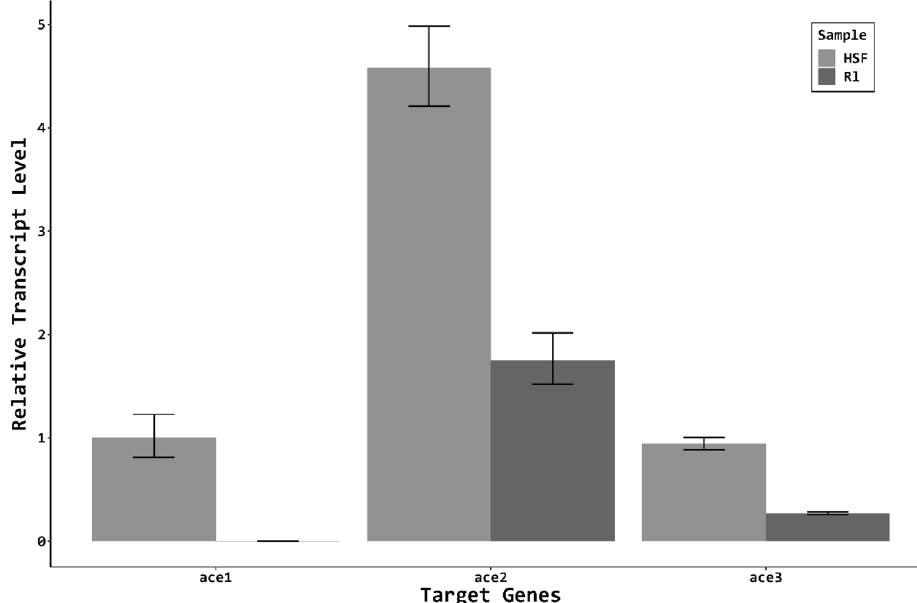
Figure 6. The relative transcript level of the three ace genes compared to a reference gene (18 s) in the two Aphelenchoides besseyi isolates. The transcript levels were normalized to the HSF AChE1 gene. Error bars represent standard errors. The experiments were performed with three biological replicates, each having three technical